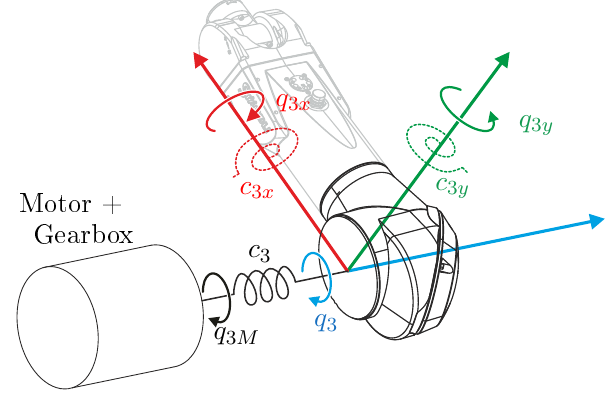
Figure 2. Model of the third